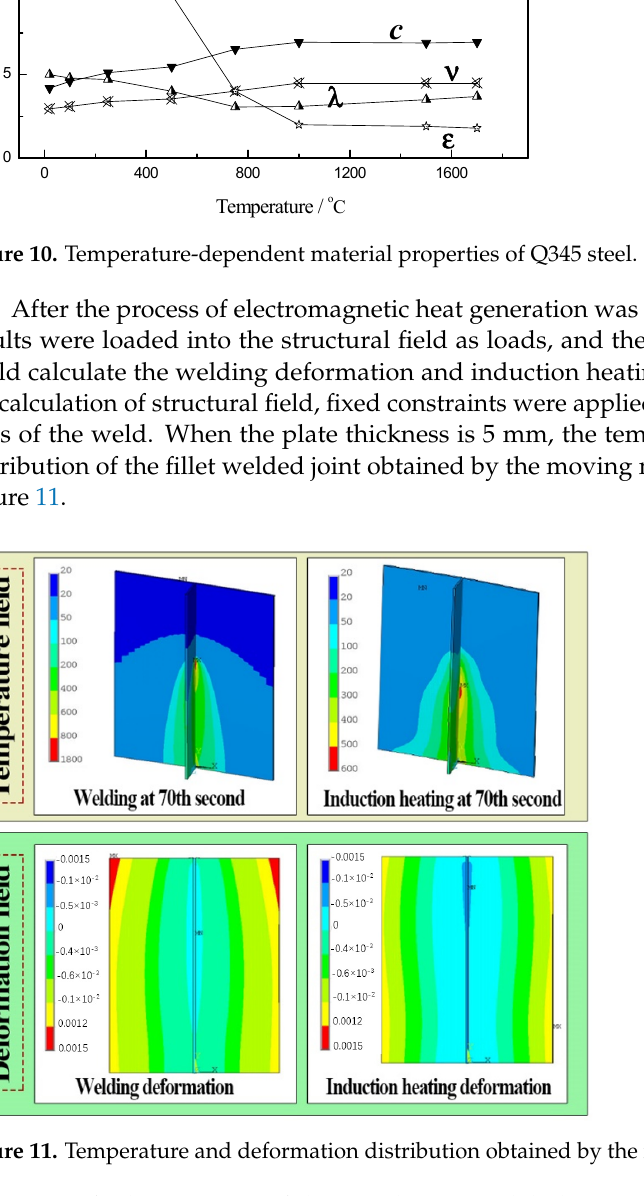
Figure 12. Comparison of the deformation between moving mesh method model and experiment. ( a ) 3 mm, ( b ) 5 mm. The induction heating model established by moving mesh method could show a dis- tribution law consistent with the experimental results. Compared the calculation results of welding deformation, the places with the greatest welding deformation were at the corners of the base plate in the direction of the end of the weld, and when the plate was thicker, the deformation was greater; when the welding deformation was larger, the effect of induction heating correction was more obvious. The maximum deformation rectifica- tion was located at the corner of the base plate, which was consistent with the experi- mental results. The deformation error obtained from experiment and simulation was large, the reason was that the constraints imposed by the model cannot be fully operated according to the actual experiment. In the study, with appropriate constraints, the whole model of welding deformation rectification by induction heating established by moving mesh method can reflect the variation law of strain field.